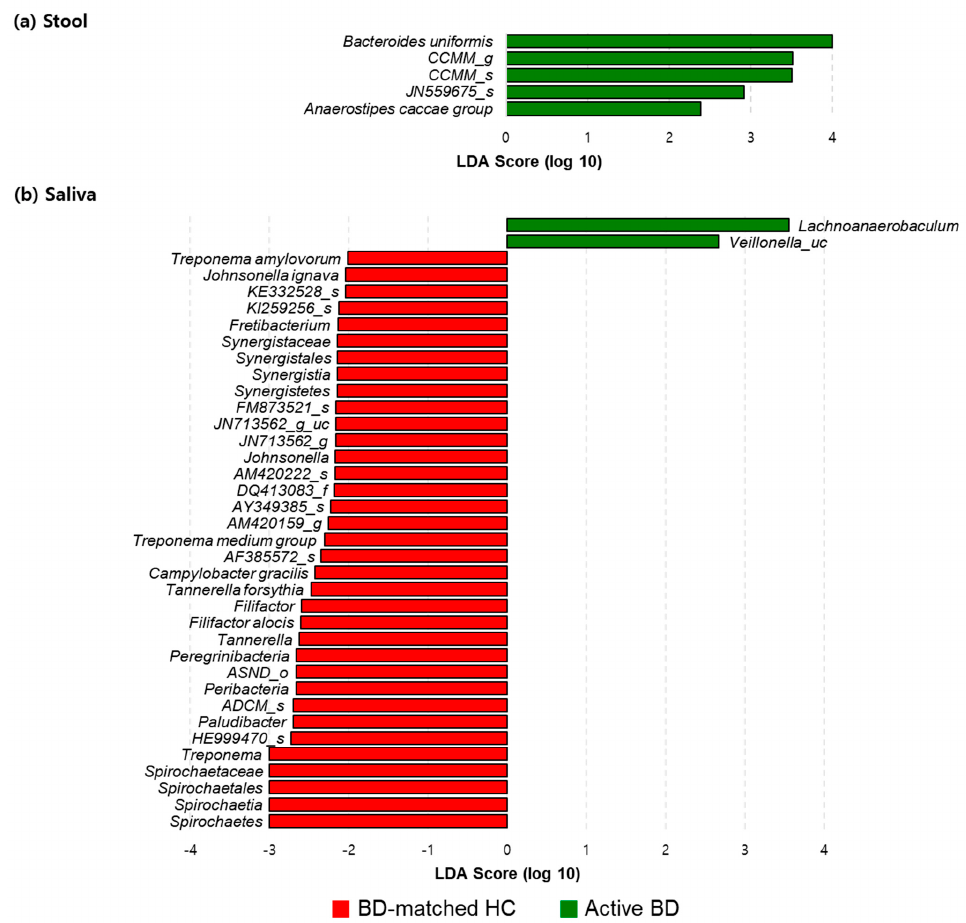
Figure 4. Relative abundances of taxa in the microbiomes of stool ( a ) and saliva ( b ) in active BD (green) and BD-matched HC (red) groups. The linear discriminant analysis (LDA) scores (log 10) were calculated using the LDA Effect Size (LEfSe) algorithm. Taxa with an LDA score (log 10) of more than 4 were Bacteroides uniformis in the stool of active BD ( p = 0.038).